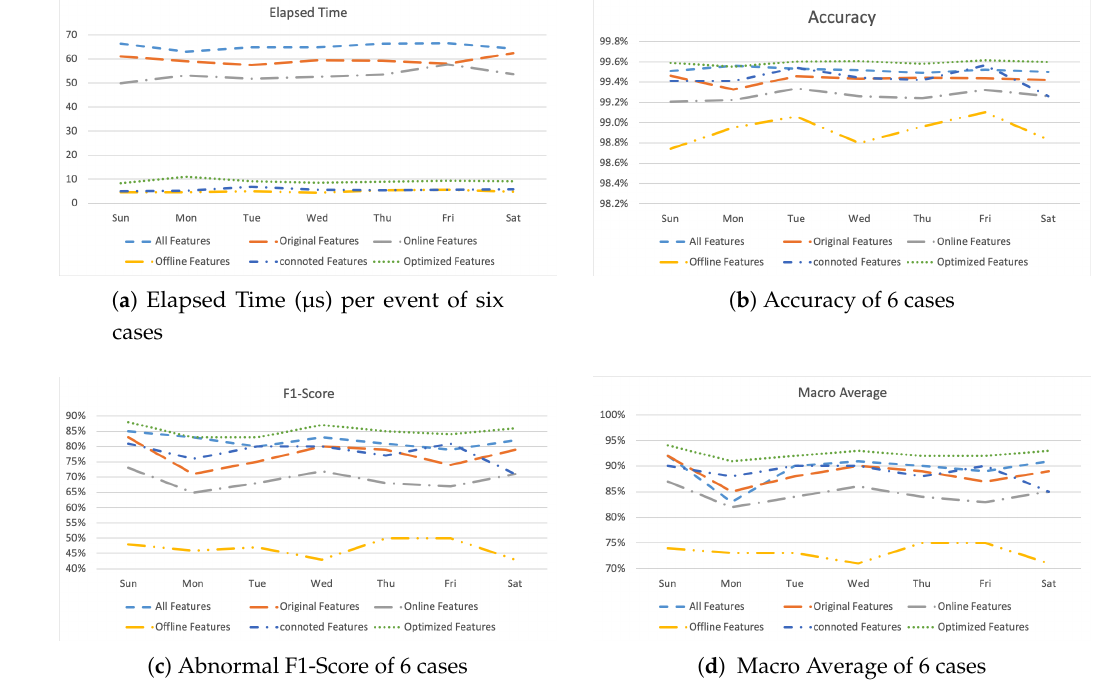
Figure 11. Comparison of feature selection.